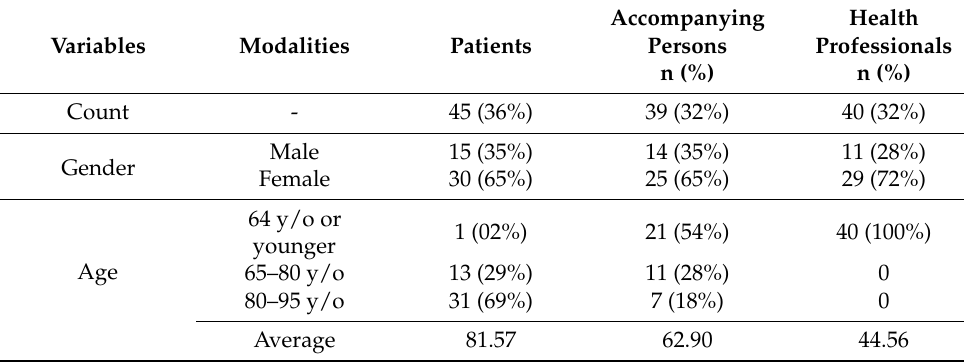
Table 3. Socio-demographic data of participants.